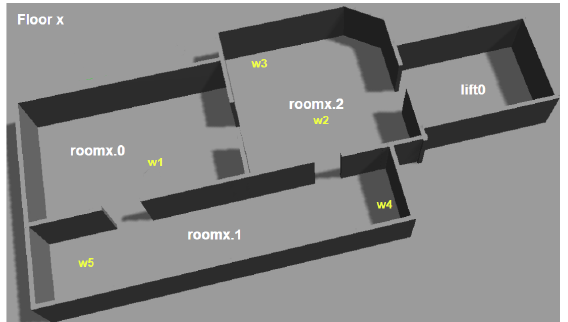
Figure 11. Gazebo simulated world used for the experiments. We use an extended version of the world originally created by Speck et al. [3]. Waypoints (e.g., w1 ) that are used during the different experiments have been indicated on the map. For all experiments there are also waypoints either side of